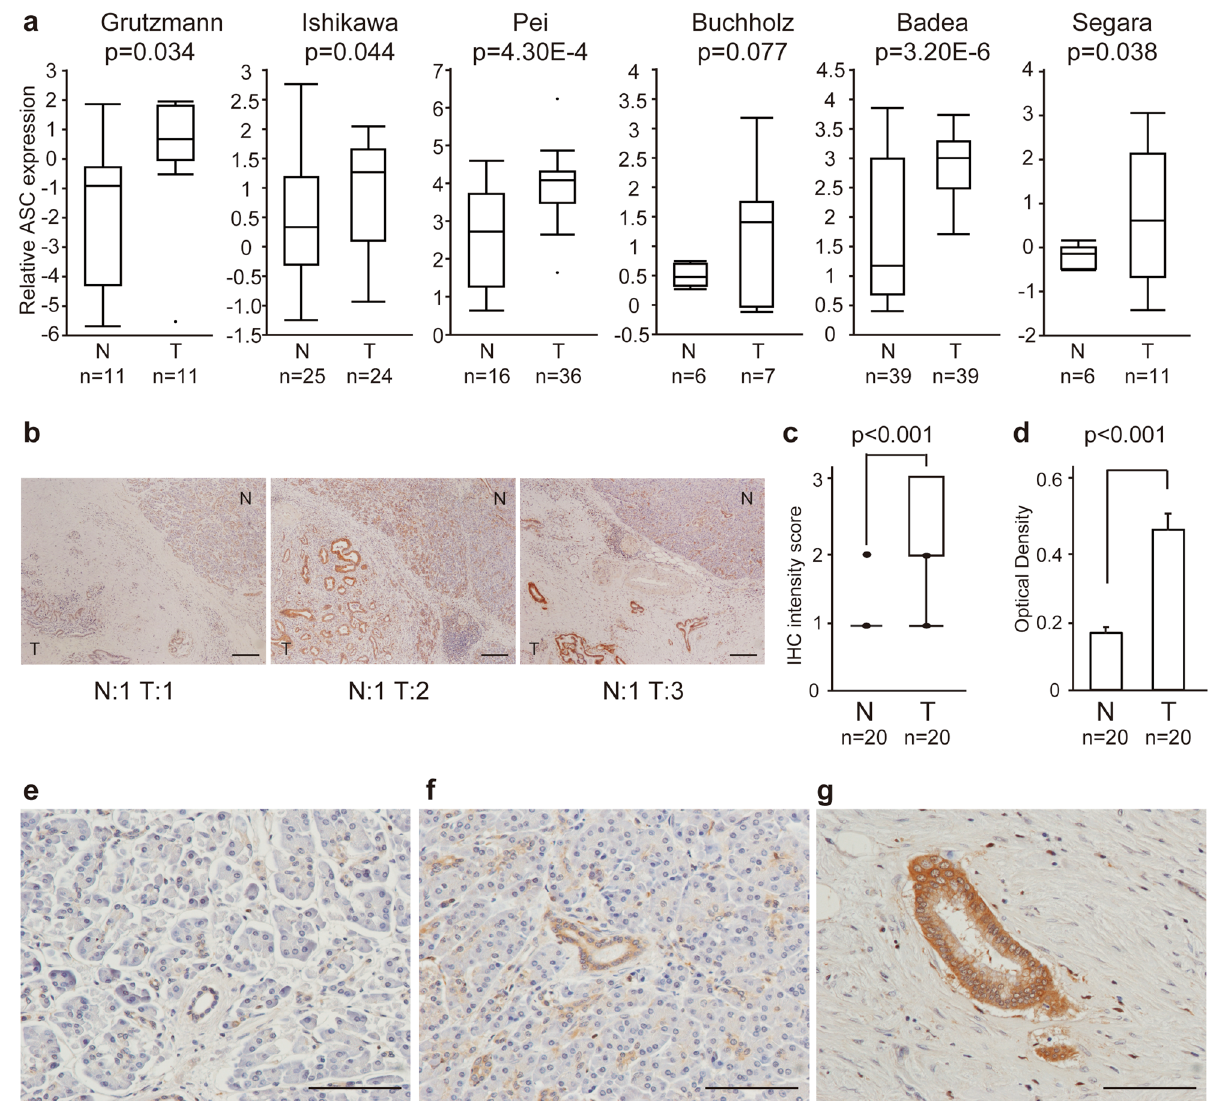
Figure 1. ASC expression according to Oncomine and clinical PDAC tissues. ( a ) Relative expression of ASC in normal/benign pancreas tissue (N) versus PDAC (T) according to six independent profiling datasets (surveyed using Oncomine). ( b ) Evaluation of ASC expression in human PDAC tissue according to IHC analysis. Data were generated from three representative PDAC tissues expressing various ASC levels and determined using the anti-ASC antibody. Scale bar: 200 μm. ( c ) IHC intensity score among 20 evaluated patients. ( d ) Immune- reaction intensity according to the OD and determined using ImageJ (n = 20). Error bars indicate the standard error of the mean based on eight independent experiments. ( e – g ) Expression of ASC protein in pancreatic tissue distant form the tumor ( e ), tissue surrounding the PDAC tissue ( f ), and PDAC tissue ( g ) according to IHC analysis. Scale bar: 100